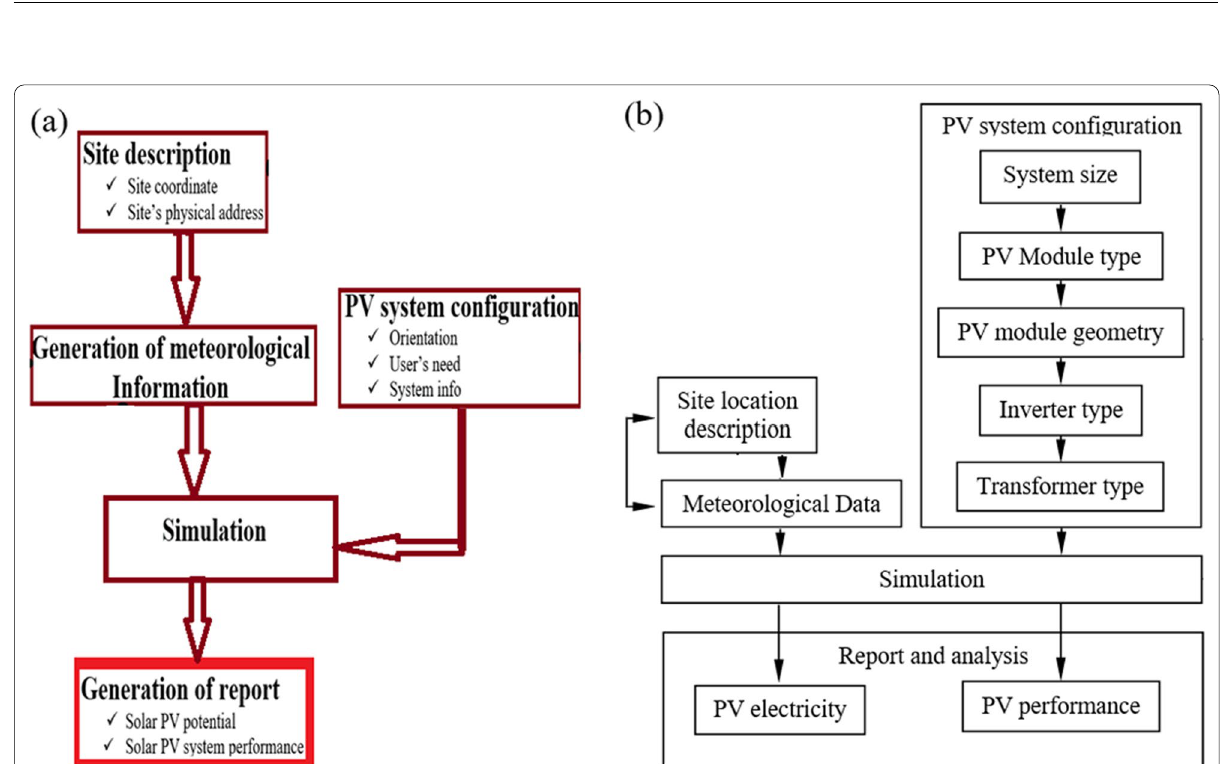
Fig. 4 A 5-stage solar PV assessment and system performance evaluation method; a block diagram of the 5-stage and b flow chart of the 5-stage